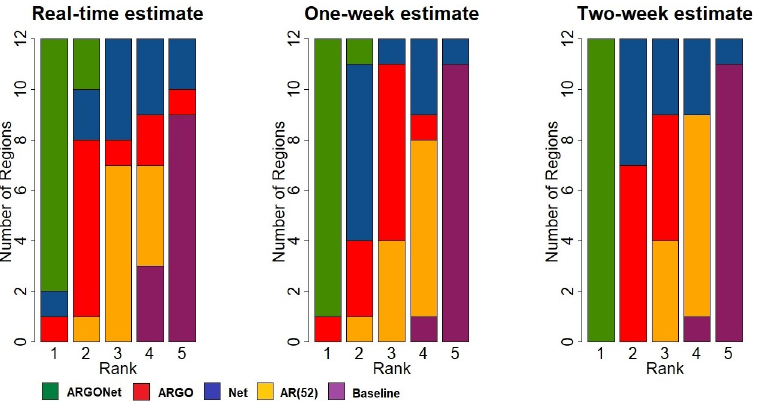
Fig 1. Ranks obtained by each model over the 12 French regions for PCC and